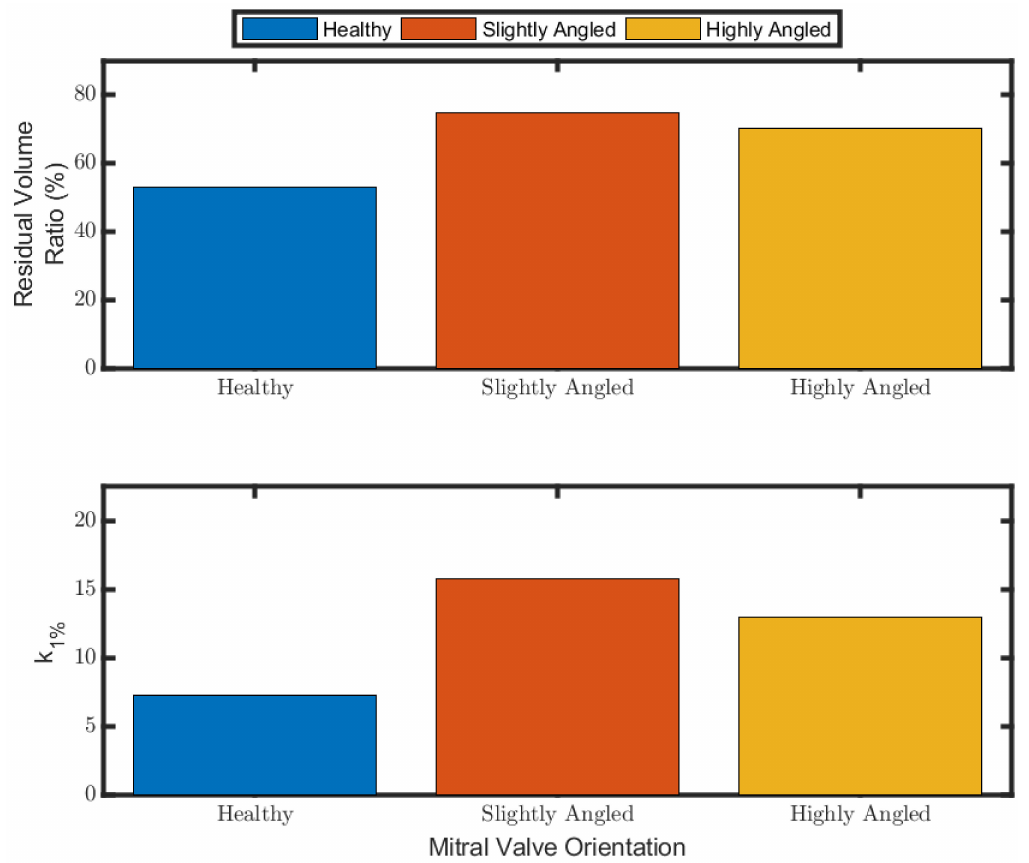
Figure 10. Residual volume ratio and the ventricular washout (k 1% ).